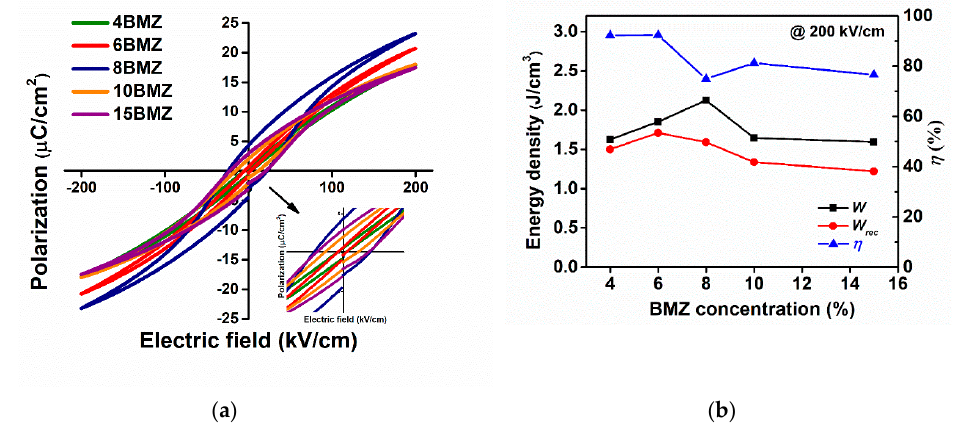
Figure 4. ( a ) The P – E loops at 200 kV / cm for (1 − x )(Sr 0.7 Bi 0.2 )TiO 3 - x Bi(Mg 0.5 Zr 0.5 )O 3 ceramics; ( b ) the stored energy density ( W ), recoverable energy density ( W r ), and energy e ffi ciency ( η ) for (1 − x )(Sr 0.7 Bi 0.2 )TiO 3 - x Bi(Mg 0.5 Zr 0.5 )O 3 ceramics as functions of di ff erent BMZ concentration at 200 kV / cm and ambient